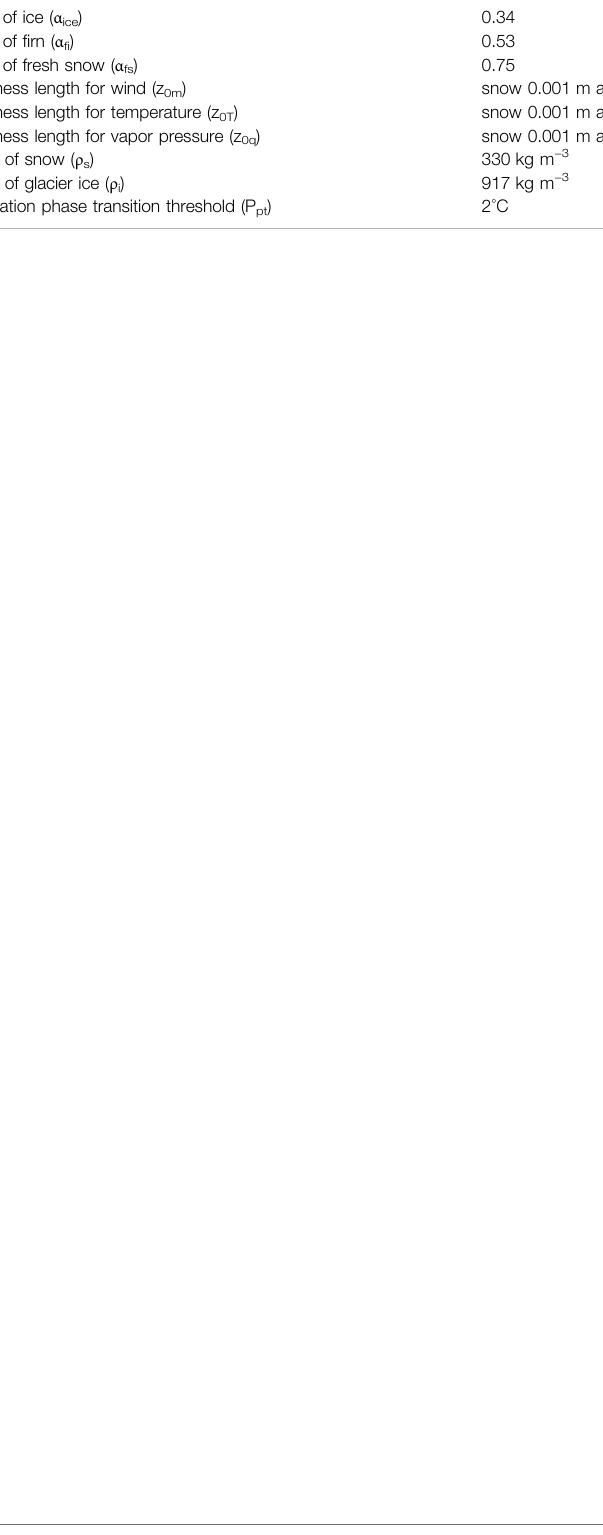
TABLE A1 | Parameters used in the model and their values. For a complete list, including constants, see Johnson and Rupper (2020).